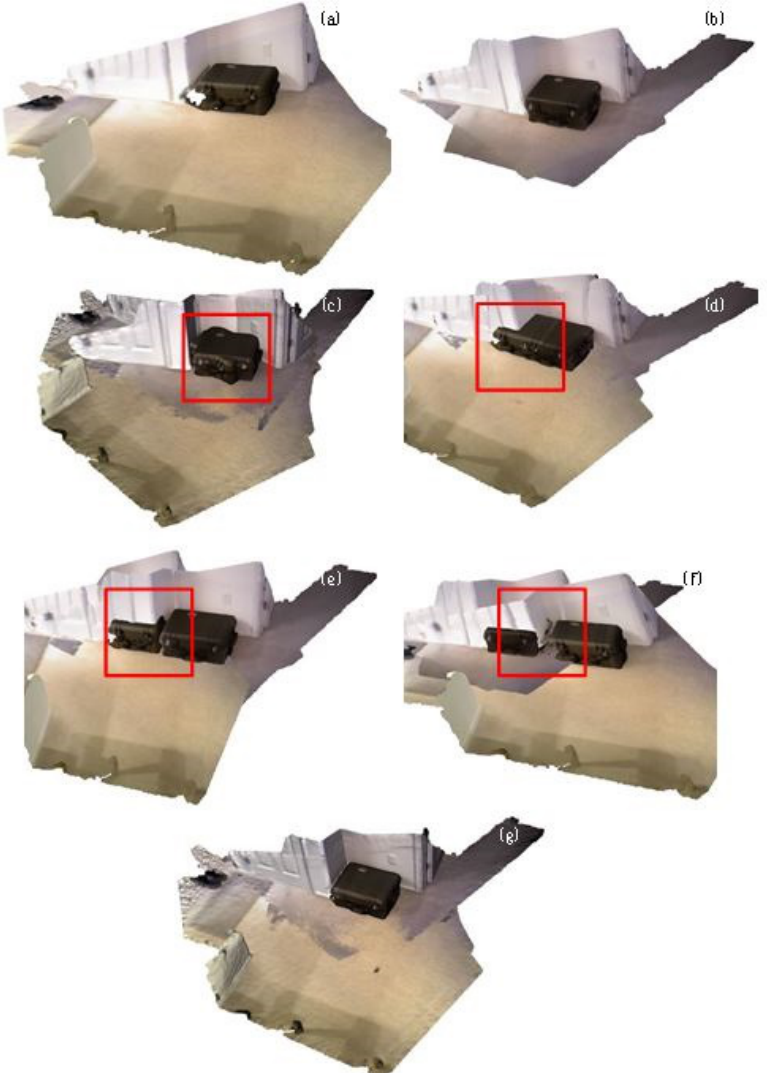
Figure 5. The registration results of the two random point clouds from dataset [14]: ( a ) source point cloud and ( b ) target point cloud. Registration results of ( c ) algorithm [14] (RMSE = 0.010607), ( d ) algorithm [20] (RMSE = 0.020071), ( e ) DeepICP (RMSE = 0.031654), ( f ) DCP (RMSE = 0.043145), and ( g ) ours (RMSE =